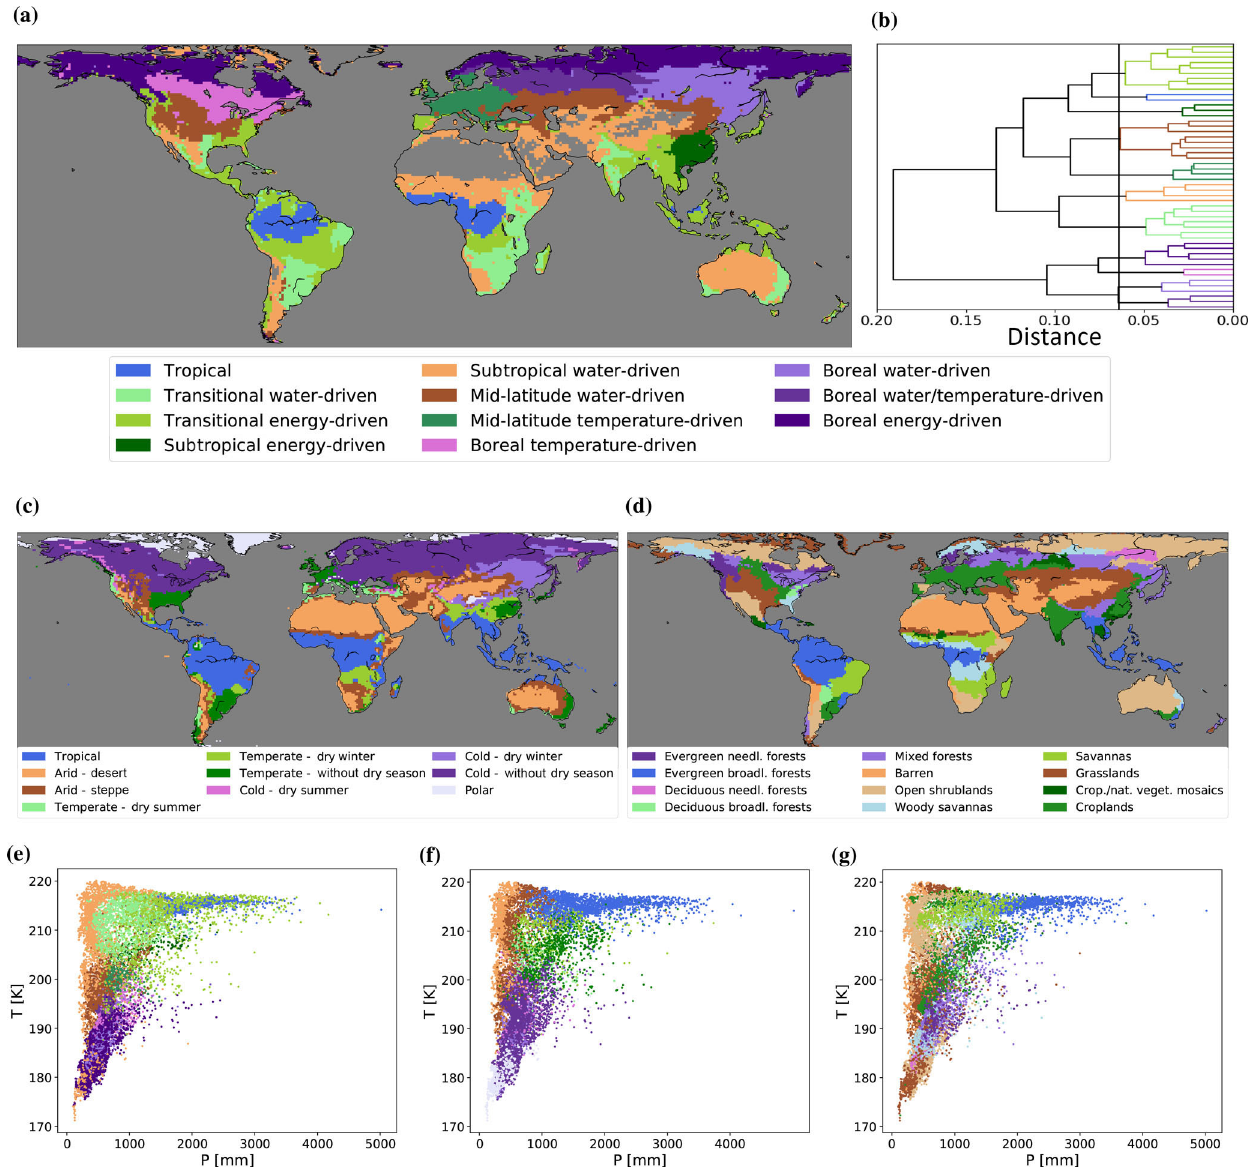
Figure 4. Comparison of the different land surface classification schemes. (a) Hydro-climatic biomes derived from the proposed framework. The region colours correspond to the colours of the clusters that are depicted in the dendrogram. (b) Dendrogram scheme of the clustering derived from the hierarchical agglomerative clustering on the low-dimensional representation of our model observations. The length of the dendrogram branches is a function of the inter-cluster dissimilarities. The vertical cutting line marks the data split into 11 clusters. The denomination of the different classes is supported by the results from Papagiannopoulou et al. (2017b). (c) Simplified Köppen–Geiger climate classification scheme. (d) IGBP land use classification scheme. (e) Climate space (i.e. mean annual temperature versus precipitation) for our hydro-climatic biomes in Fig. 4a. (f) Same as (e) but for the Köppen–Geiger climate classes in Fig. 4c. (g) Same as (e) but for IGBP in Fig.